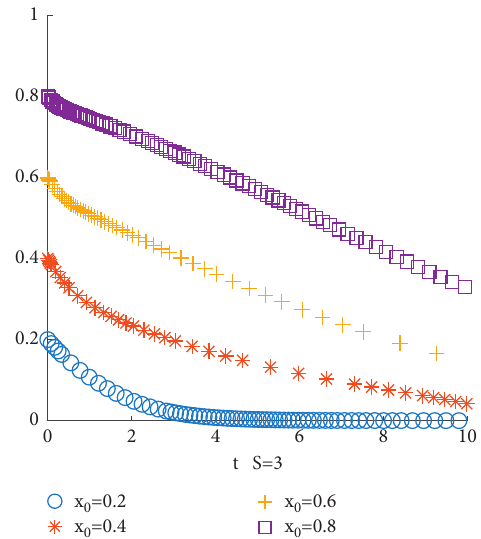
Figure 9: The impact of owners’